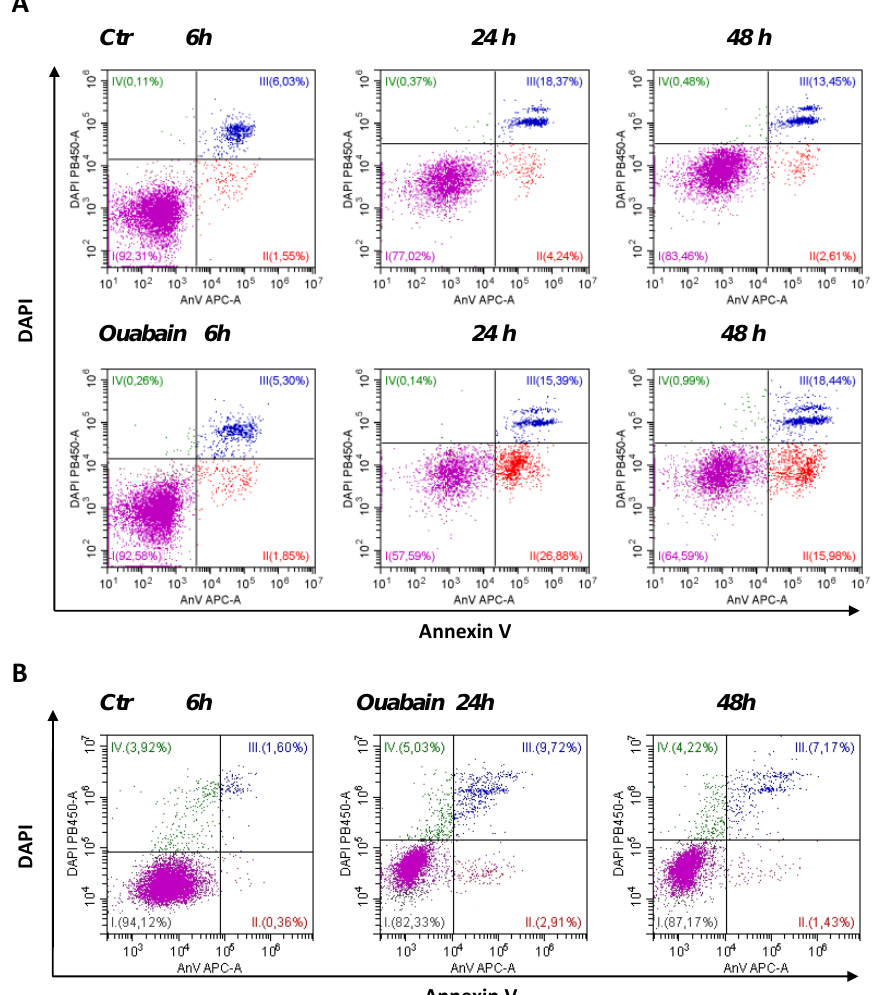
Figure 2. Ouabain induces apoptosis in eMSCs cultivated in three-dimensional spheroids rather than in a monolayer. ( A ) Apoptosis assay of eMSCs in spheroids obtained by the hanging drop method and exposed to ouabain. AnnexinV/DAPI flow cytometry cytograms (dot plots) measured in 3D eMSCs, control (Ctr) and treated with 1 µ M ouabain for 6, 24, and 48 h. Data from one experiment out of four performed on the same protocol. ( B ) Annexin V/DAPI double staining with monolayer (2D) eMSCs, control and treatment with 1 µ M ouabain for 24 and 48 h. AnV-/DAPI-live cells (I); early apoptotic AnV+/DAPI- cells (II); late apoptotic cells AnV+/DAPI+ (III). DAPI+AnV- necrotic cells (IV).